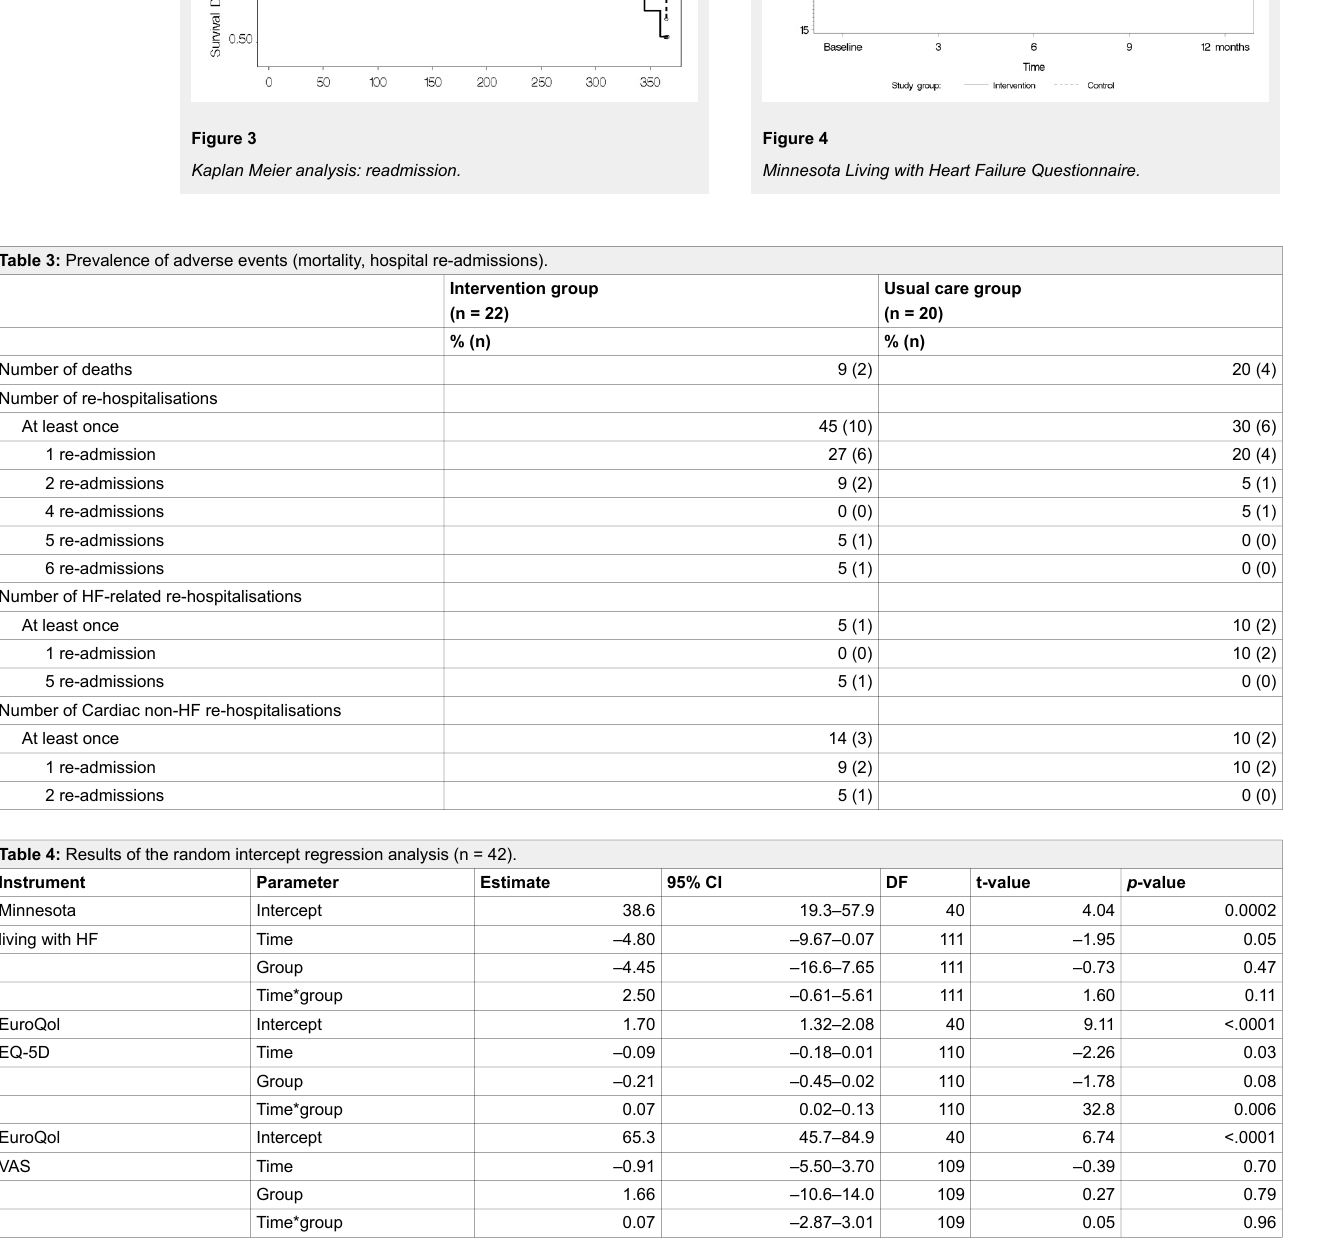
Table 4: Results of the random intercept regression analysis (n =